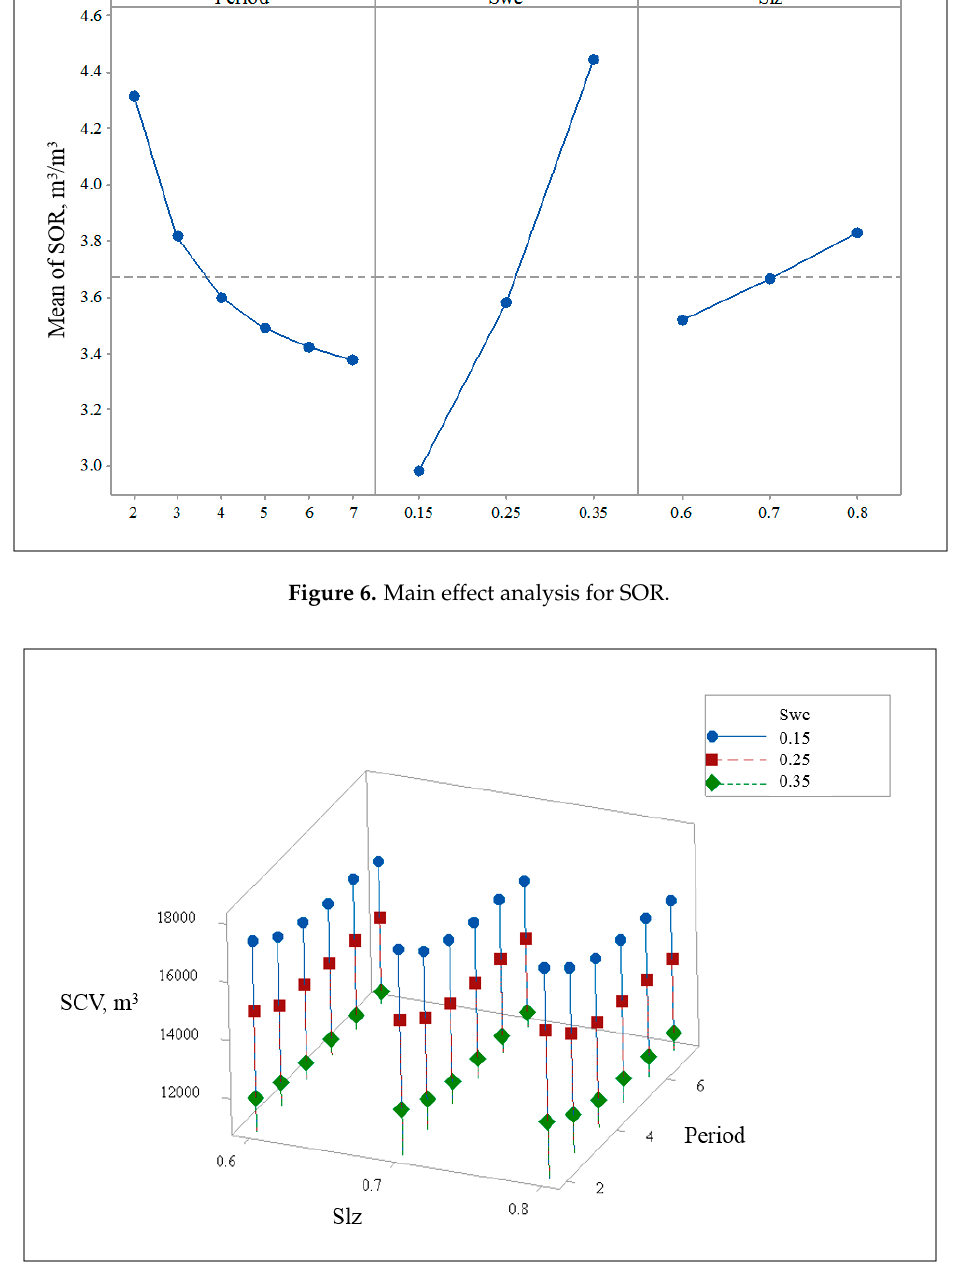
Figure 7. Relationship between width, interval distance, thickness, and SCV.